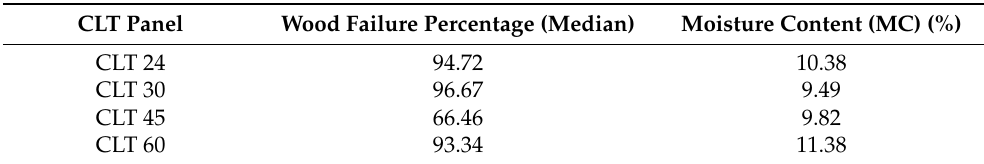
Table 2. Wood failure percentages of CLT manufactured from densified and undensified laminas under